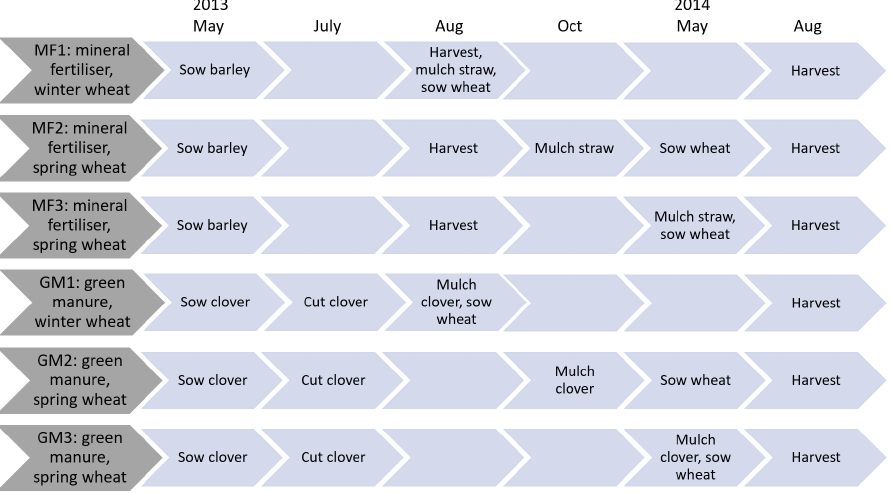
Fig. 1. Timeline of the